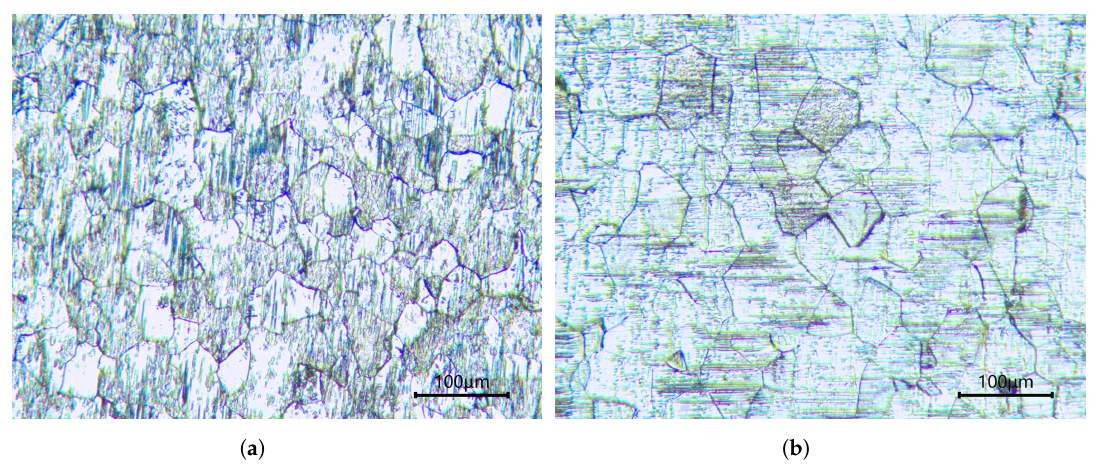
Figure 1. Microstructure on TA2 plate surface ( a ) before and ( b ) after annealing treatment The Hammer peening process, as illustrated in Figure 2, uses a self-made electric hammer process system comprised of an electric hammer, bracket, frequency converter, and fixture. Inside the electric hammer, the air pressure piston powered by the motor strikes the push hammer to force the deputy hammer, causing the deputy hammer to affect the punch tool to impact the test specimen with a certain kinetic energy, and changing the hammer tool can alter the size of the tool head. The bracket keeps the electric hammer in a specific posture and controls the speed of the electric hammer in the plane during machining; the frequency converter outputs alternating current at a certain frequency to control the speed of the motor, and then regulates the impact kinetic energy; the fixture holds the test plate to maintain its fixed position and initial shape.